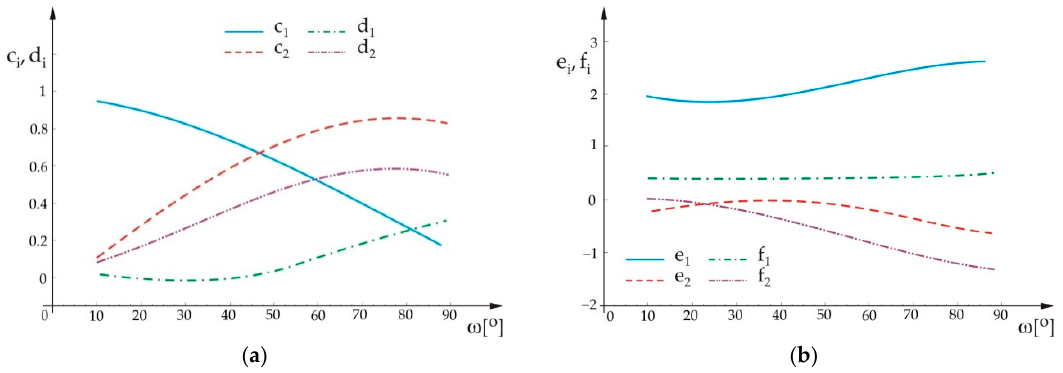
Figure 2. Solutions for the complex coefficients c , d , e , and f as functions of angle ω . ( a ) Solutions for the complex coe ffi cients c and d as functions of angle ω . ( b ) Solutions for the complex coe ffi cients e and f as functions of angle ω .